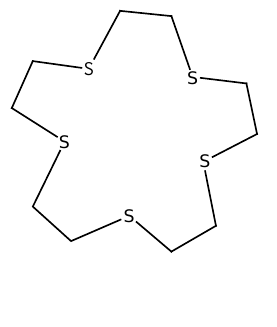
Figure 40. Pentathia-15-crown-5.